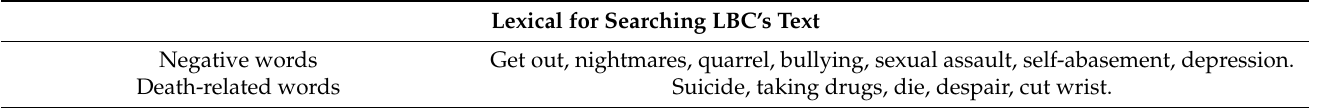
Table 4. Key words for data extraction. Lexical for Searching LBC’s